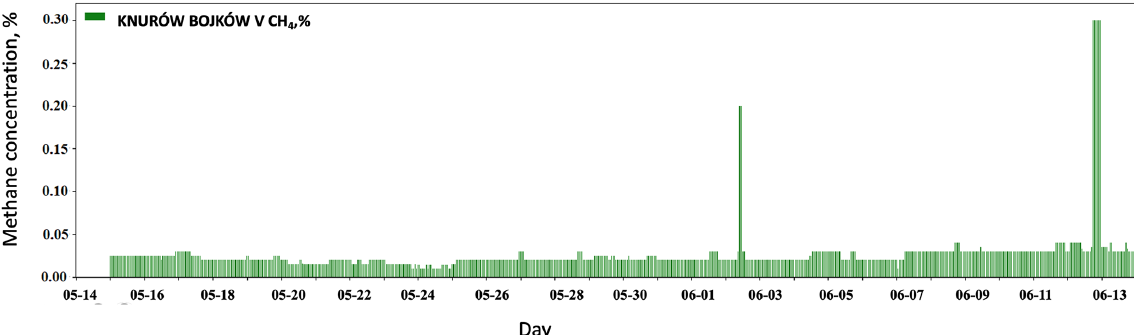
Figure 8. Variability of hourly data of methane concentration in the Knurów Bojków V coal mine in the period from 14 May to 13 June 2018.